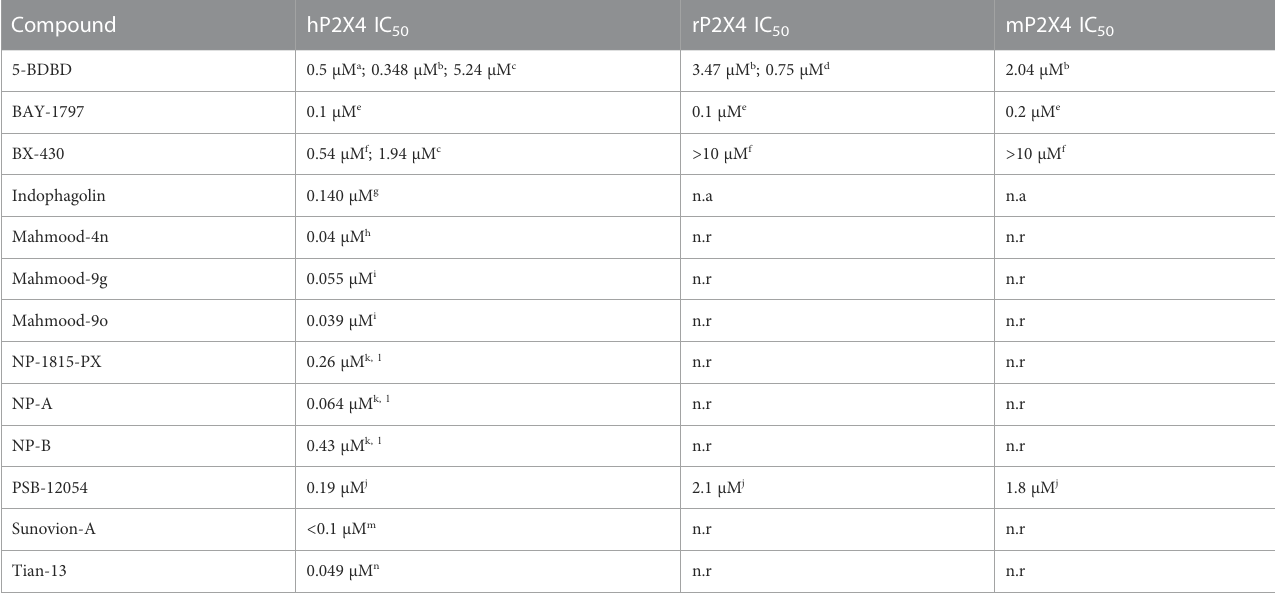
TABLE1Reported potencies for knownP2X4antagonists. n.r,Notreported. a Fischer etal.(2004); b Abdelrahmanetal.(2017); c Sophocleous etal.(2020); d Coddou etal. (2019); e Werner et al. (2019); f Ase et al. (2015); g Carnero Corrales et al. (2021); h Mahmood et al. (2022a); i Mahmood et al. (2022b); j Hernandez-Olmost et al. (2012); k Matsumura et al. (2016), and l Ushioda et al. (2020) m Newcom and Spear (2013); n Tian et al. (2020).